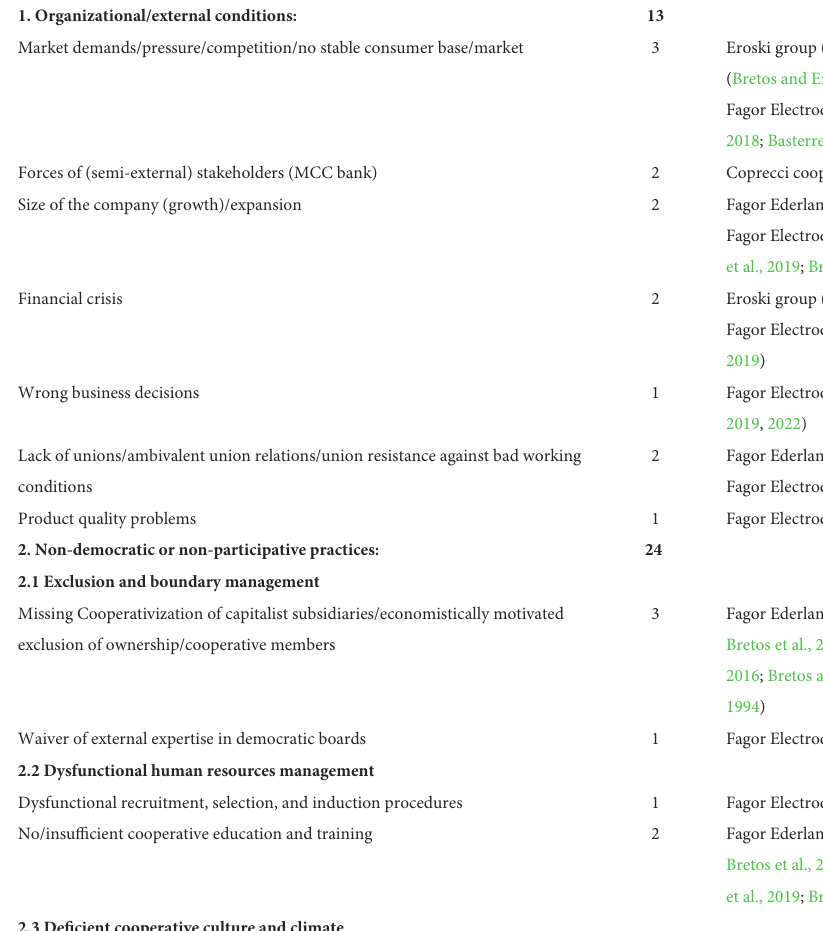
TABLE 7 Frequencies of conditions, practices, and psychological phenomena of all forms of degeneration tendency mentioned ( n = 6 cases of the Mondragon Cooperative Corporation). Conditions, practices, and psychological phenomena Frequency Enterprise groups and